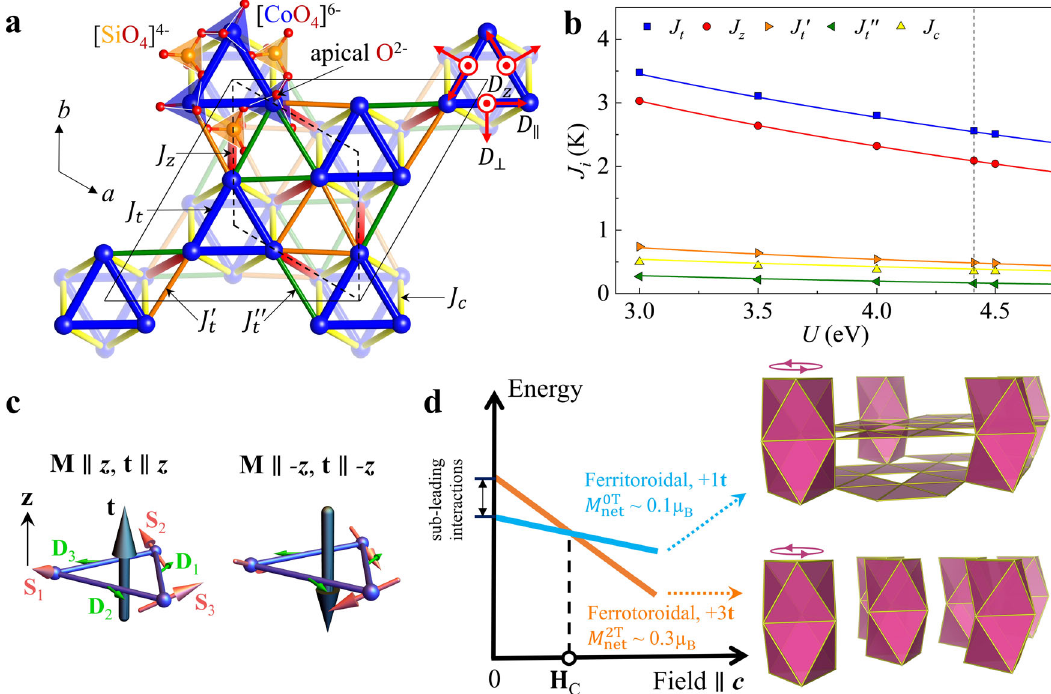
Fig. 3 Microscopic magnetic model and the underlying mechanism for the ferritoroidal to ferrotoroidal transition. a Magnetic exchange pathways of BaCoSiO 4 , showing three intralayer couplings f J t ; J 0 t ; J 00 t g and two interlayer couplings { J z , J c }. Three components of a DM vector on the nearest-neighbor J t bonds are indicated by red arrows in a local reference frame. b Density functional theory calculation of exchange interaction strengths as a function of onsite interaction U . The dashed line marks the set of couplings with U = 4.41 eV that matches the Weiss temperature from the magnetic susceptibility (Table S2). c Minimal energy con fi gurations for three spins { S i , i = 1, 2, 3} on a triangle with an antiferromagnetic Heisenberg interaction and an in-plane DM interaction. The DM vectors { D i , i = 1, 2, 3} (green arrows) are related by 3-fold rotation symmetry and have the same sense of rotation as the tilting of apical oxygens shown in panel ( a ). Each vector makes an ~30° angle with the bond, see main text for details. For this set of DM vectors, the resulting spin structure (pink arrows) generates a toroidal moment t (black arrows) that is always parallel to the magnetization M . d Energy balance between the ferri- to ferrotoroidal state in magnetic fi elds. The “ frustrated ” triangular units that do not have 120° con fi gurations (and cost more energy) are highlighted in pink for both states. The ferrotoroidal state has less colored triangles in the ab plane; therefore, it is energetically favored by the interactions f J 0 t ; J 00 t g , similarly the ferritoroidal state is favored by the interaction J c . Competition between these subleading interactions results in the ferritoroidal structure with a lower energy in zero fi eld. The transition to the ferrotoroidal state occurs when the energy difference is compensated by the Zeeman energy in magnetic fi